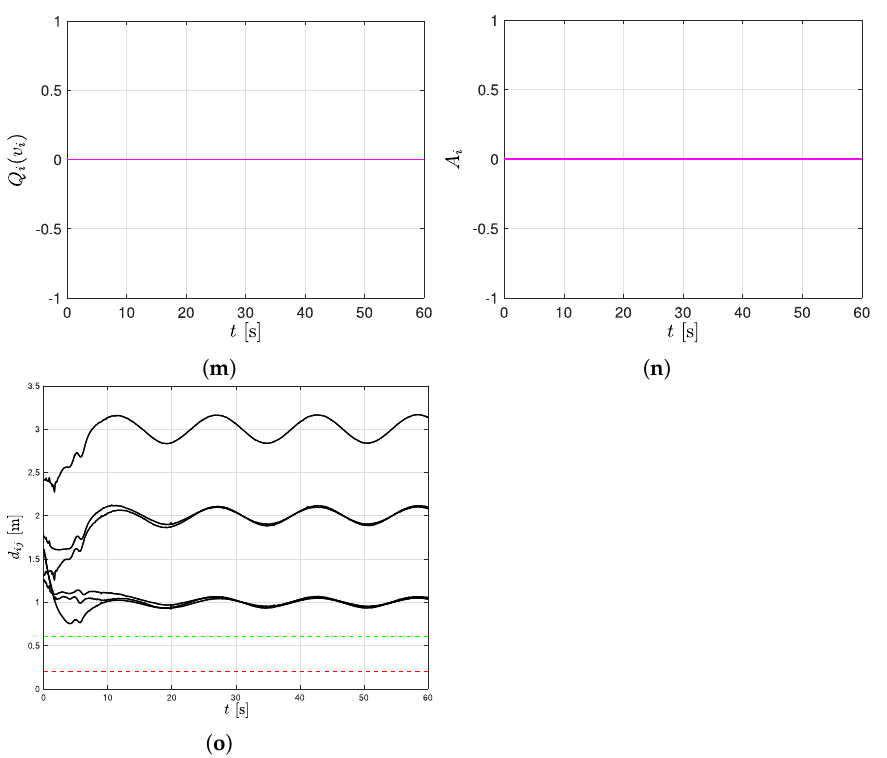
Figure 7. Experiment EX2—robots execute circular trajectory. ( a ) Locations of the robots on xy -plane. ( b – d ) Time plots of x, y coordinates and robot orientations respectively. ( e – g ) Position and orientation errors respectively. ( h , i ) Linear and angular velocity controls. ( j , k ) Angular velocities of the wheels. ( l ) ‘freeze’ signals. ( m ) activation of the procedure described in Assumption 4 ( n ) Collision avoidance component of the control Equation (21) ( o ) Distances between